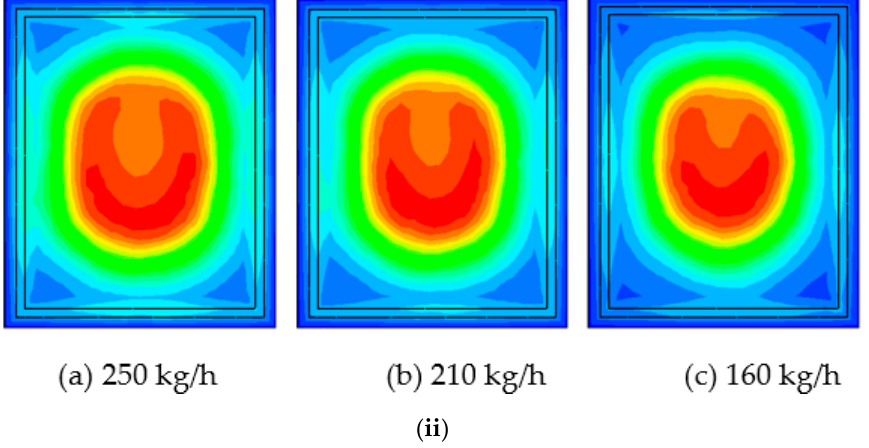
Figure 9. Temperature field of the burner exit (XY cross section) for different oil feed rates when the extension distance was 300 mm and 400 mm. ( i ) Extension distance of 300 mm (K), ( ii ) extension distance of 400 mm (K).